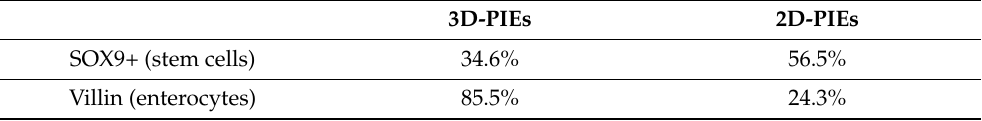
Table 1. Cell population comparison between 3D and